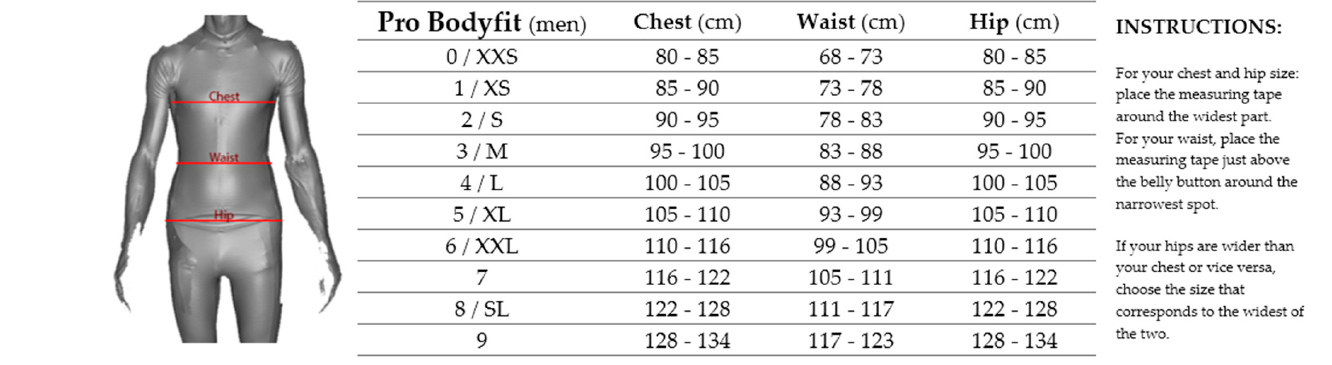
Figure 1. Example of the sizing chart for male subjects of the professional Bodyfit garment range with instructions on how to measure and select garments (Redrawing from [7]).